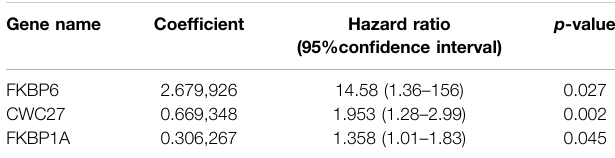
TABLE 2 | Most prognosis-related PPIase